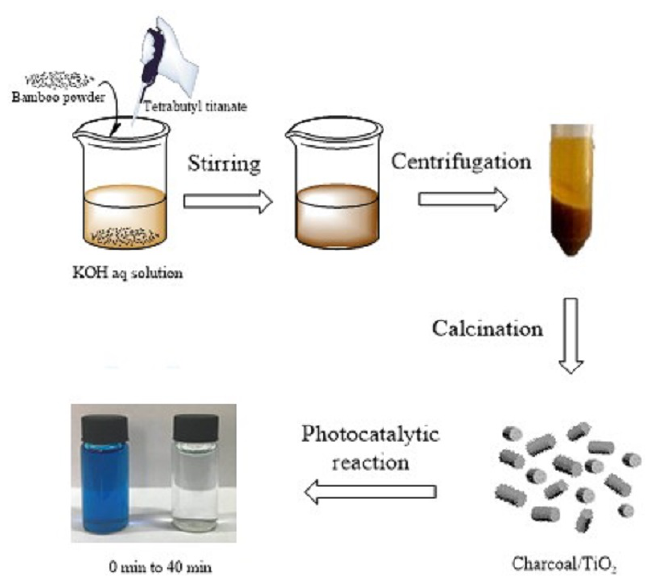
Figure 1. Schematic image of the preparation and photocatalytic property of bamboo charcoal/TiO 2 composites.